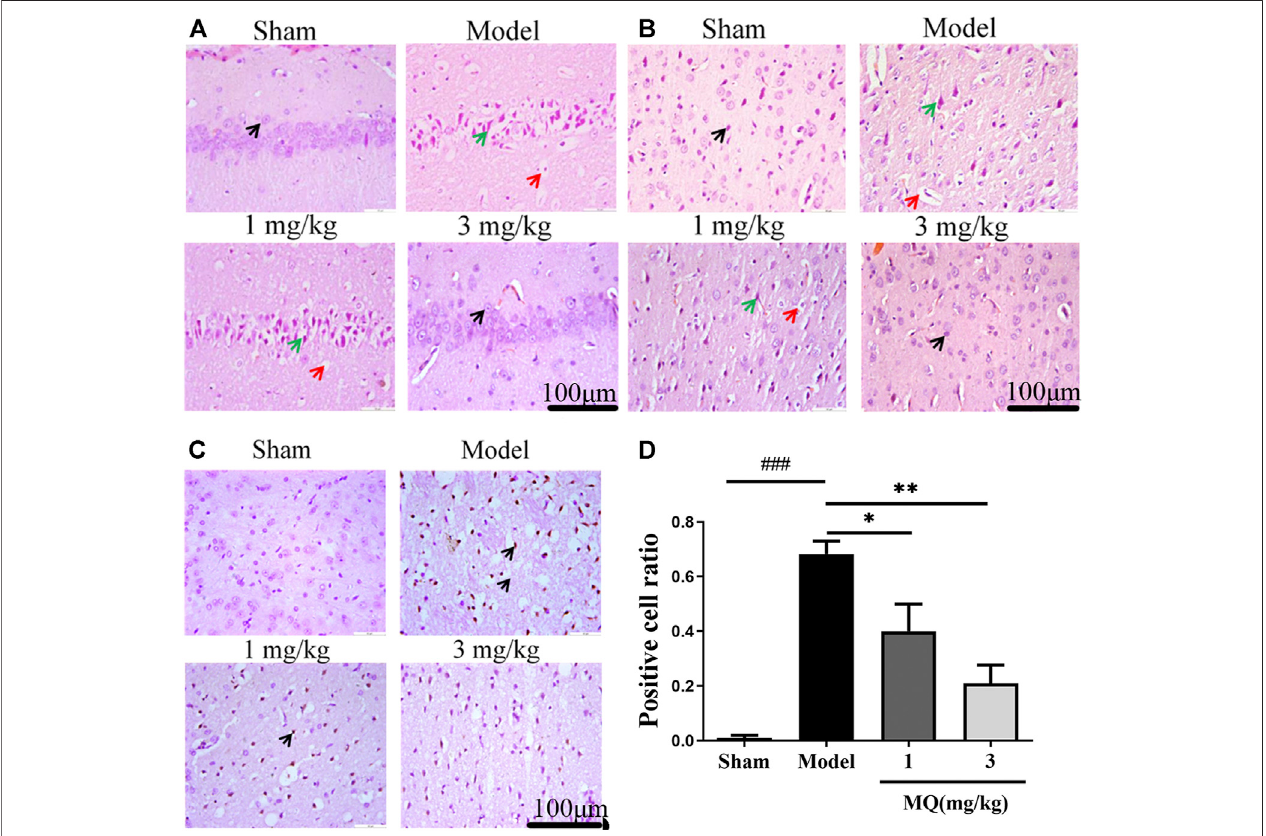
FIGURE 2 | MQ reduced cell apoptosis of the brain in MCAO rats. (A) The hippocampi were stained with H&E (magni fi cation × 400), (B) the cortices were stained with H&E (magni fi cation × 400). Normal neurons (black arrow), atrophic neurons (green arrow), and cavitation edema neurons (red arrow), (C) the cortices were stained withTUNEL(magni fi cation × 400)(D)ThepercentageofpositivecellsafterI/Rindifferentgroups. ### p < 0.001,Shamgroupvs.Modelgroup;** p < 0.01,Modelgroupvs. 3 mg/kg group; * p < 0.05, Model group vs. 1 mg/kg group, n (cid:2)